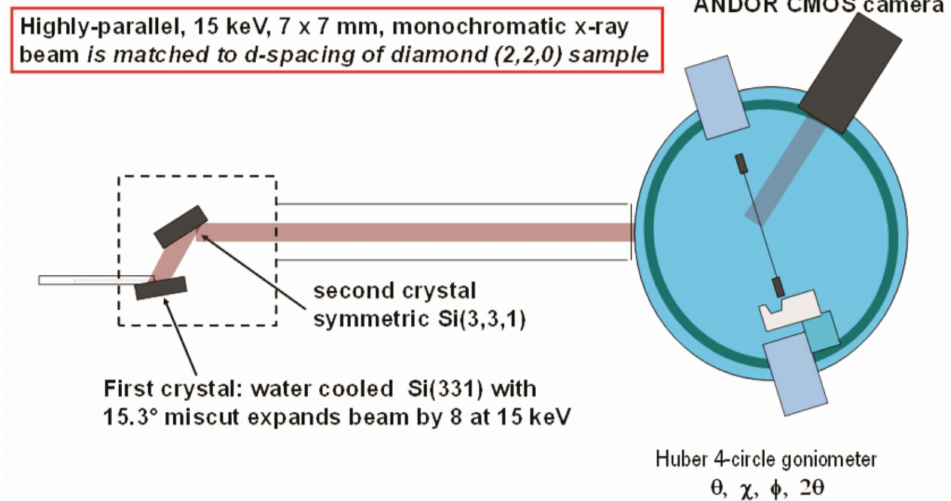
Figure 1. C1 beam line setup at Cornell High Energy Synchrotron Source (CHESS), Ithaca, NY, USA. The sample is held at room temperature. The figure is taken from ref. [33], which is published on the website of CHESS Cornell, USA, ref. [33]: Finkelstein, K.; Jones, R.; Pauling, A.; Brown, Z.; Tarun, A.; Jupitz, S.; Sagan, D.; Misra, D.S.; 2016 . http://news.chess.cornell.edu/articles/2015/Finkelstein151 123.html (accessed on 7 April